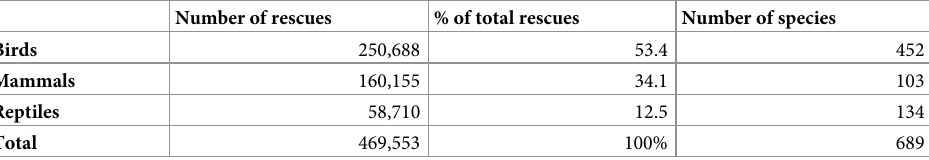
Table 2. Number of rescues and species reported for each animal group during the study